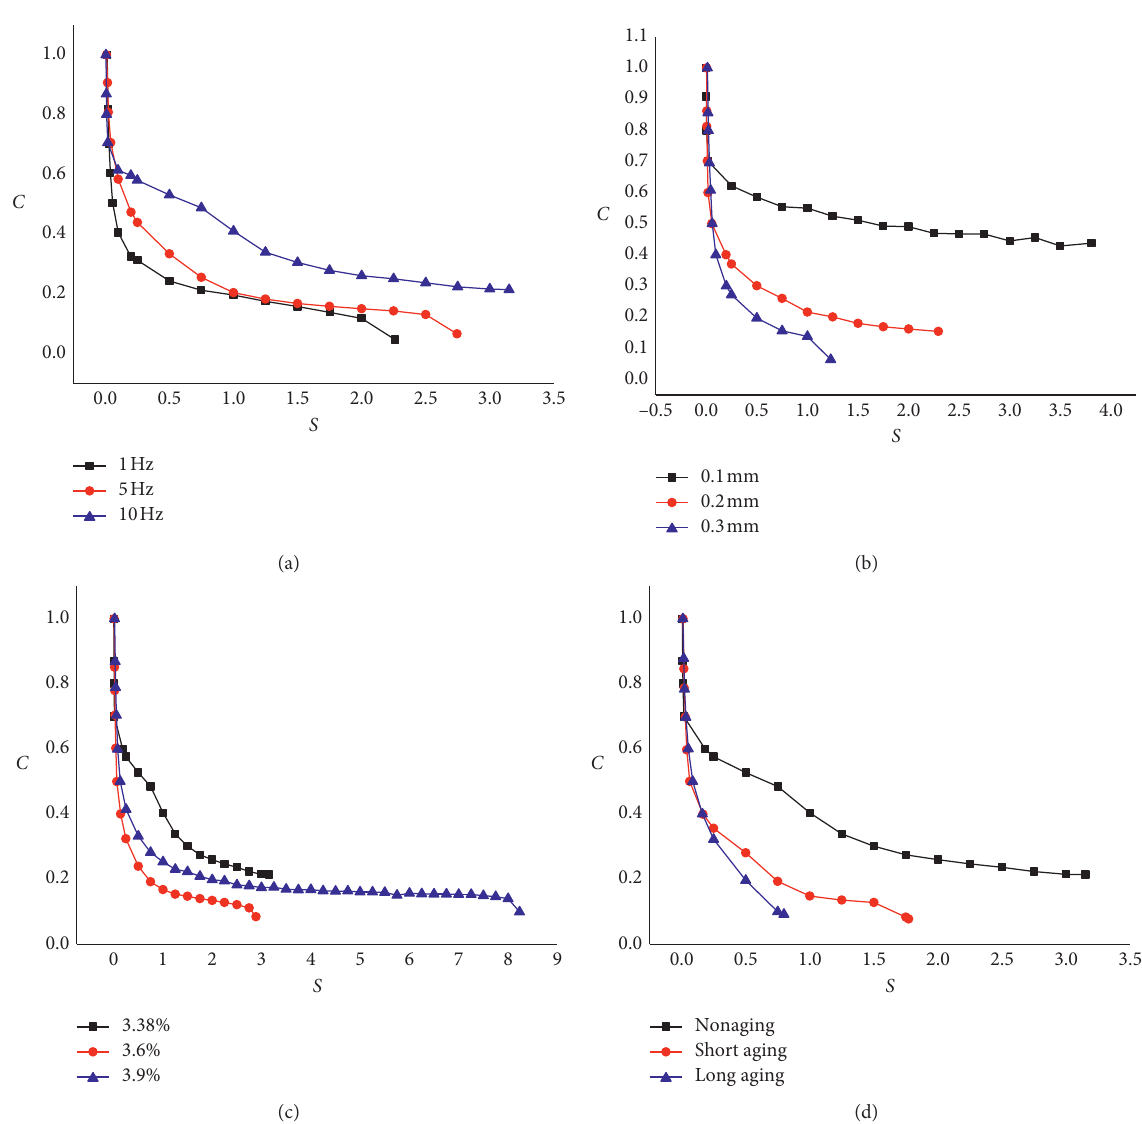
Figure 4: Damage characteristic curves corresponding to (a) frequency, (b) displacement, (c) asphalt-aggregate ratio, and (d) aging